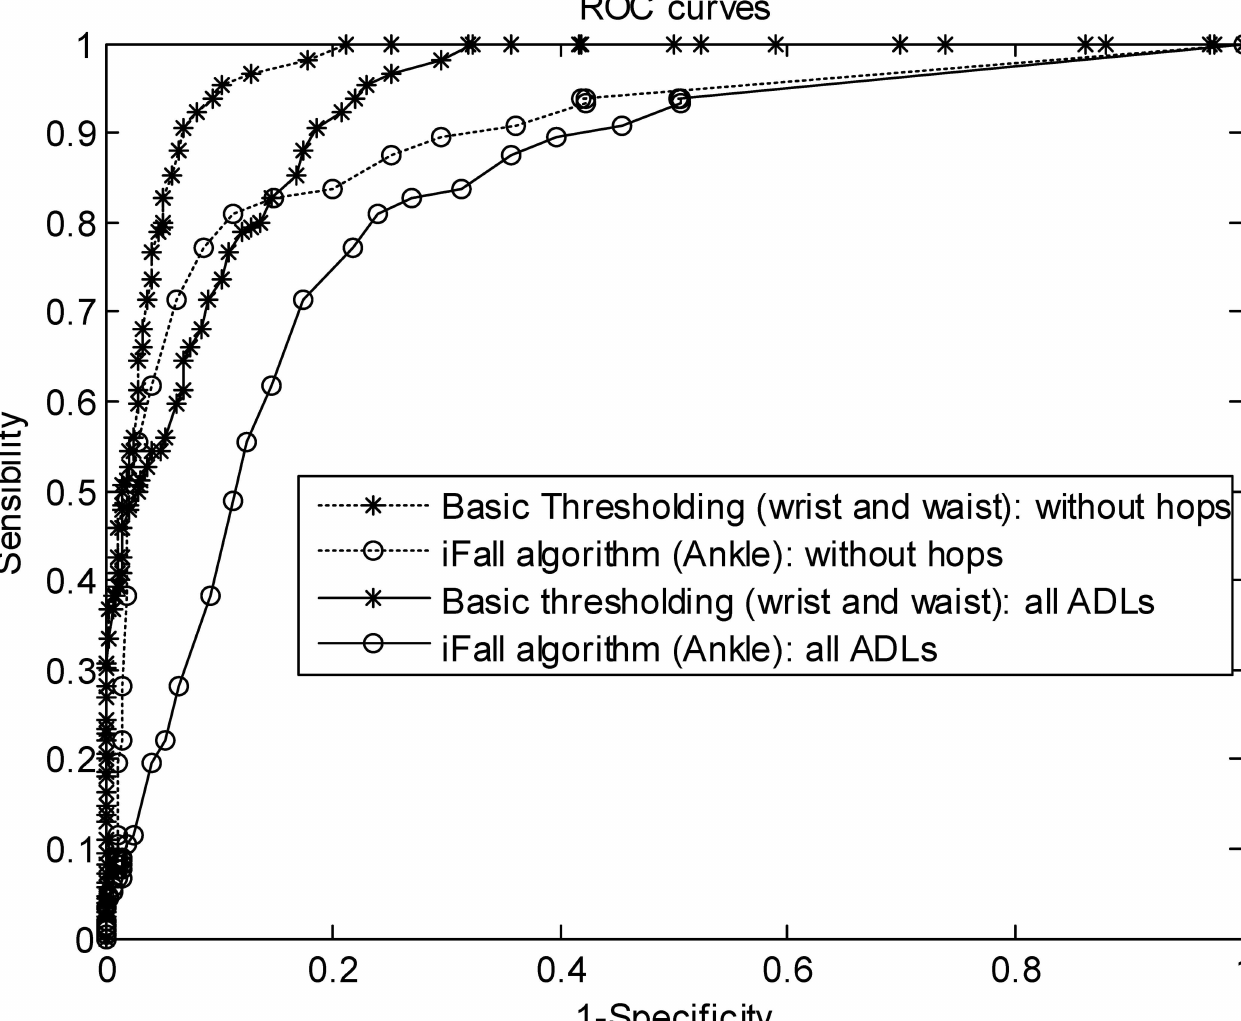
Fig 3. ROC curves obtained for the best and worst combinations of sensor positions and algorithms for the cases where samples generated by hops are included and excluded from the test